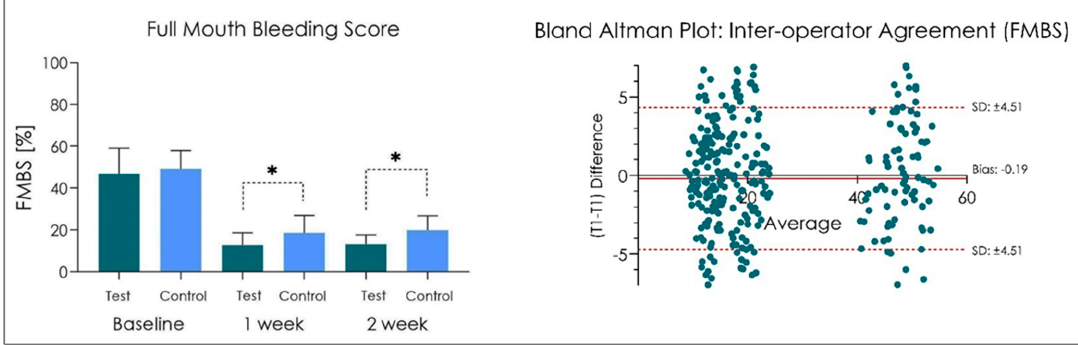
Figure 4. Gingival index score at baseline, after 1 and 2 weeks. * p < 0.05. One-way ANOVA followed by Tukey’s post-hoc test. 3.2. Study Outcomes FMPS score recorded at baseline (V2) were 54.20 ± 10.8 in the Group Test and 58.2 ± 6.1 in the Group Control ( p > 0.05). After 1 week (V3), FMPS was 13.3 ± 5.6 in the Group Test and 18.7 ± 4.3 in the Group Control ( p < 0 .05), while at V4 (2 weeks), FMPS was 14.2 ± 4.1 in the Group Test and 20.3 ± 5.2 in the Group Control ( p < 0.05) (Figure 2). The Pearson coefficient revealed a FMPS inter-operator r: 0.849 (Figure 2). FMBS score recorded at baseline (V2) was 46.7 ± 8.7 in the Group Test and 49.2 ± 6.2 in the Group Control ( p > 0.05) (Figure 3). After 1 week (V3), FMBS was 12.7 ± 4.2 in the Group Test and 18.5 ± 5.9 in the Control Group ( p < 0.05), while after 2 weeks (V4), it was 13.1 ± 3.2 in the Group Test and 19.8± 4.9 Group Control ( p < 0.05) (Figure 3). The Pearson coefficient showed a FMBS inter-operator r: 0.958 (Figure 3). The Gingival Index data measured at different experimental times, at Baseline, 1 week, and 2 weeks, are presented in Figure 4. The gingival index score (GI) recorded at baseline (V2) was 2.75 ± 0.17 in Group Test and 2.71 ± 0.11 in the Group Control ( p > 0.05). After 1 week (V3), FMPS was 1.14 ± 0.55 in the Group Test and 1.75 ± 0.49 in the Group Control ( p < 0.05), while at V4 (2 weeks), FMPS was 1.09 ± 0.44 in the Group Test and 1.96 ± 0.39 in the Group Control ( p < 0.05). The Spearman coefficient reported a GI inter-oper- ator r: 0.874 (Figure 3).